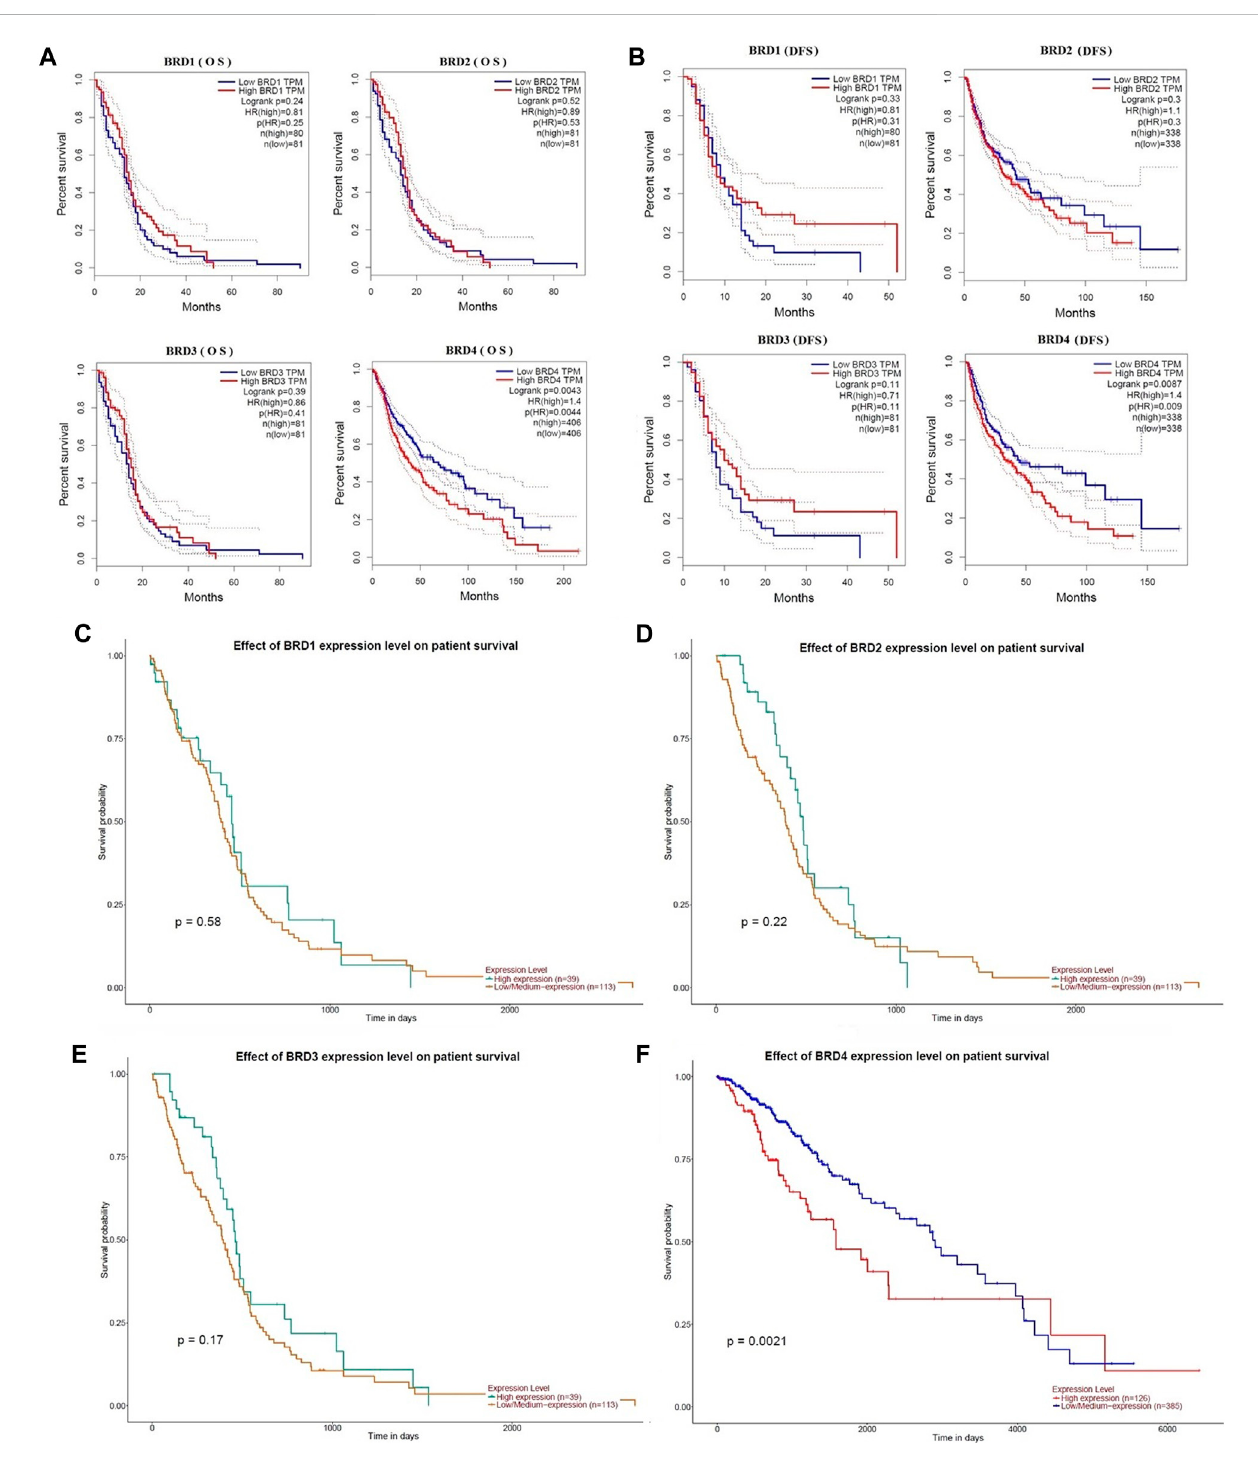
FIGURE 3 The prognostic value of BET genes in GBM patients from the GEPIA database. The survival curves were plotted using the Kaplan – Meier Plotter. (A) The overall survival rate (OS) of BRD1, BRD2, BRD3 and BRD4 mRNA, respectively. (B) The disease-free survival rate (DFS of BRD1, BRD2, BRD3 and BRD4 mRNA, respectively. (C – F) The effect of BRD1, BRD2, BRD3 and BRD4 expression level on patient survival from UALCAN database,